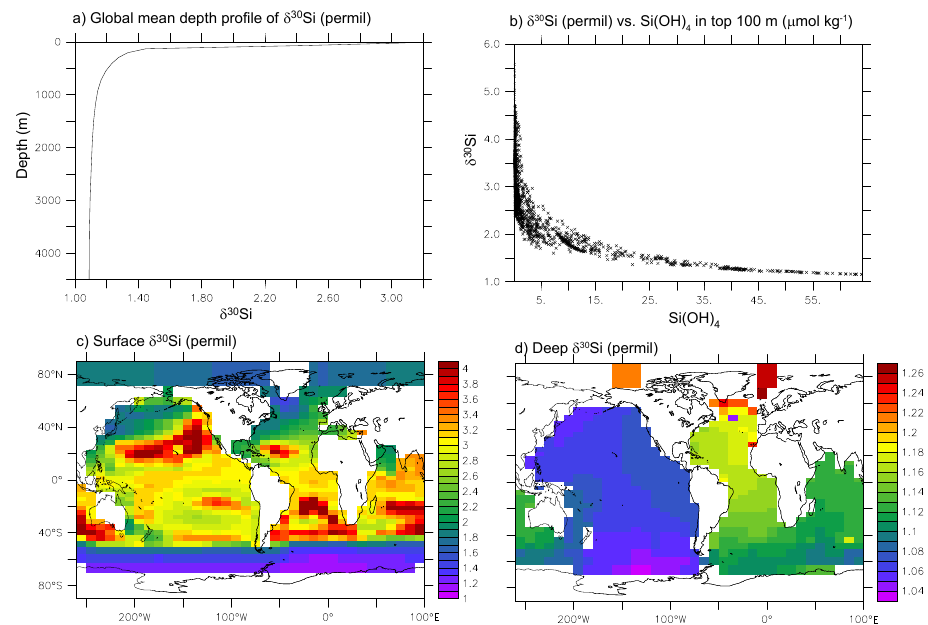
Fig. 11. Simulated annual mean δ 30 Si from MESMO 2: (a) global mean vertical profile; (b) relationship to Si(OH) 4 ; (c) surface distribution; and (d) deep distribution